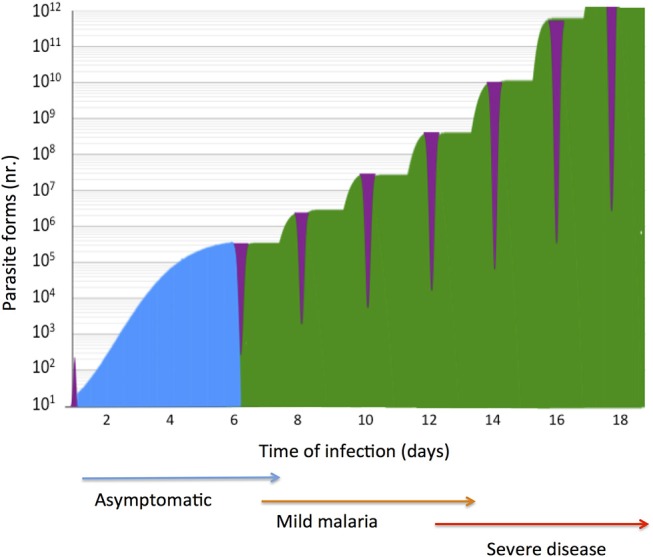
Natural history of malaria infection in a naïve susceptible host. P. falciparum expansion in the liver and in blood stage infection is represented in a logarithmic scale. Exposure of parasite extra-cellular forms (purple) to the host immune system is brief in case of sporozoites (<1 h) and momentaneous in the case of free merozoites in the blood (few minutes). In a typical infection liver stage parasites (blue) expand in few dozens of hepatocytes in circa 5.5 days, a clinically unapparent phase (blue arrow). Synchronous blood stage parasite expansion is represented (green), considering six rounds of trophozoite division during erythrocytic schizogony. In naïve individuals blood stage infection causes tertian fever (one brood infection) and mild malaria (brown arrow) but the clinical severity (red arrow) is co-determined by parasite pathogenicity factors and by the host genetic make-up.